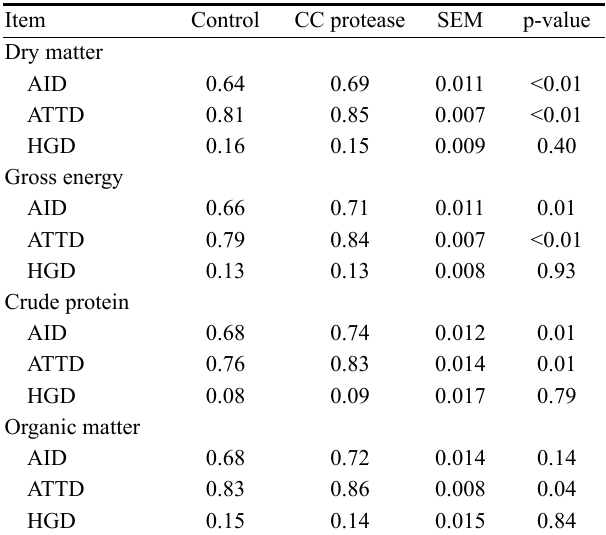
Table 6. Apparent ileal (AID), total tract digestibility (ATTD) and hindgut digestibility (HGD) of nutrients in basal diet or diet supplemented with 0.2 g/kg proteases (Exp.